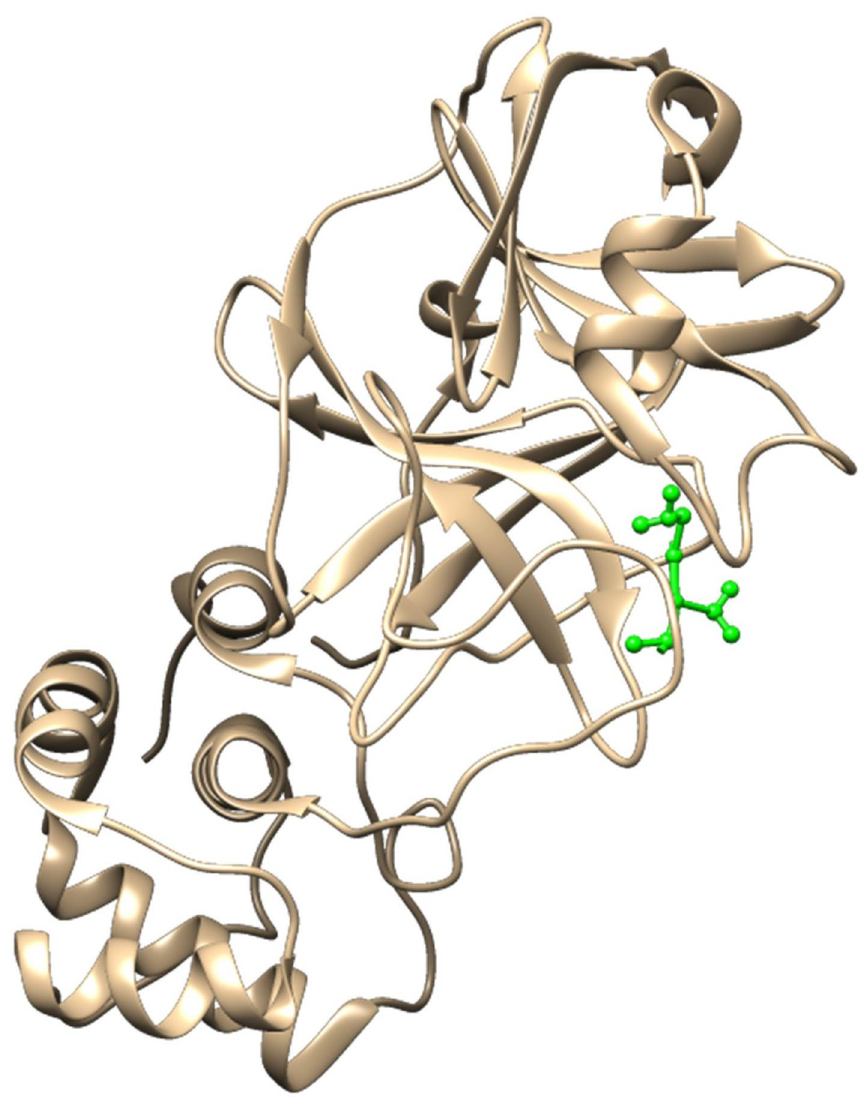
Fig 1. Image representation of ligand-receptor